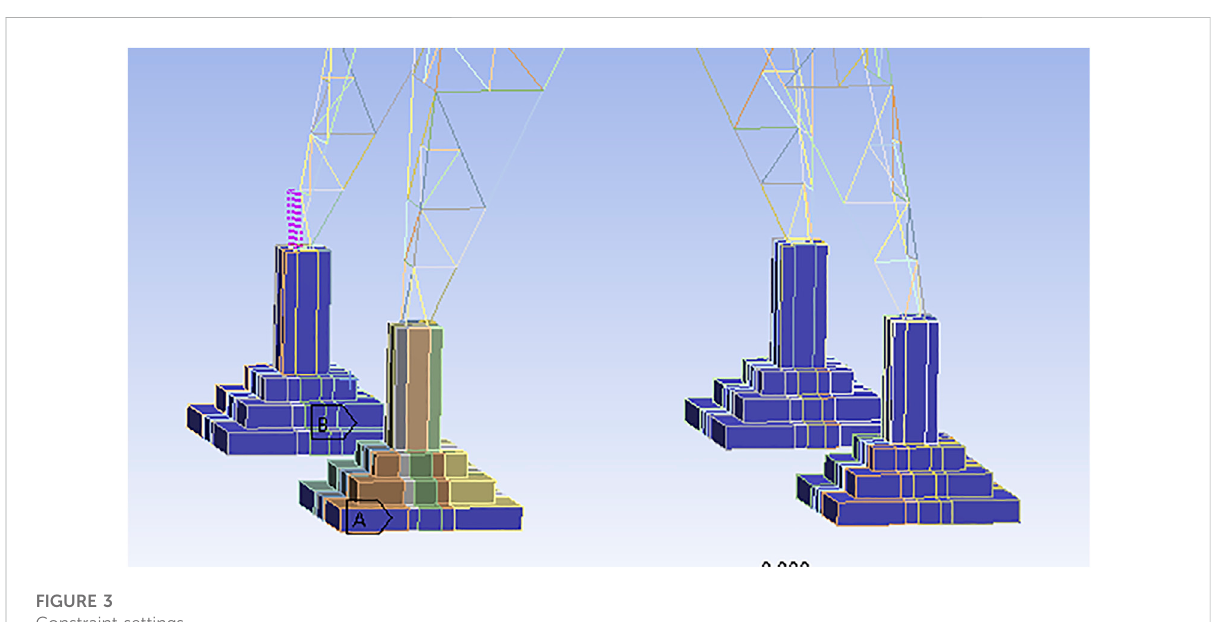
FIGURE 3 Constraint